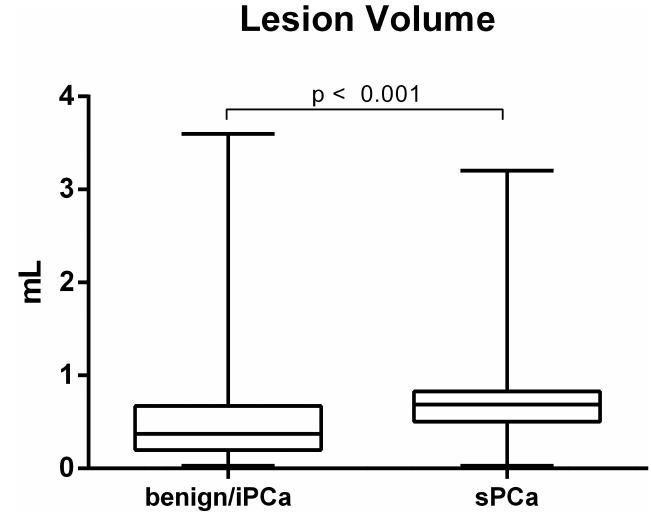
Figure 3. Lesion volume in benign/indolent and significant PCa